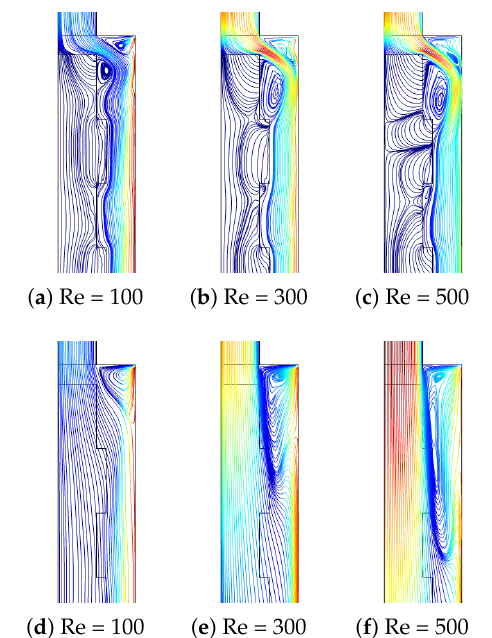
Figure 6. F-P variations with varying Re at two different permeabilities of the PL (( a – c ), Da = 10 − 5 ), (( d – f ), Da = 10 − 1 ) (Rew = 1000, Ha = 7.5, ax = 0.25 ap, N =